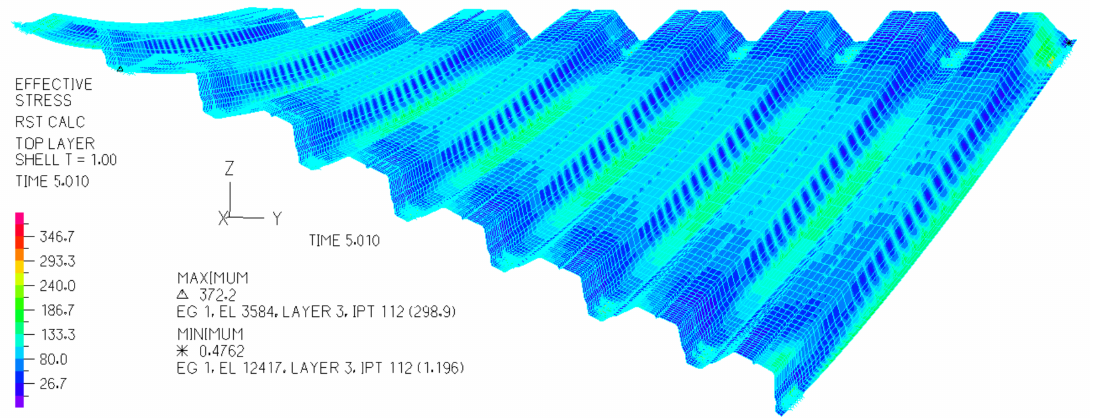
Figure 4. An exact computational folded model of a nominally plane folded sheet transformed into a shell shape.